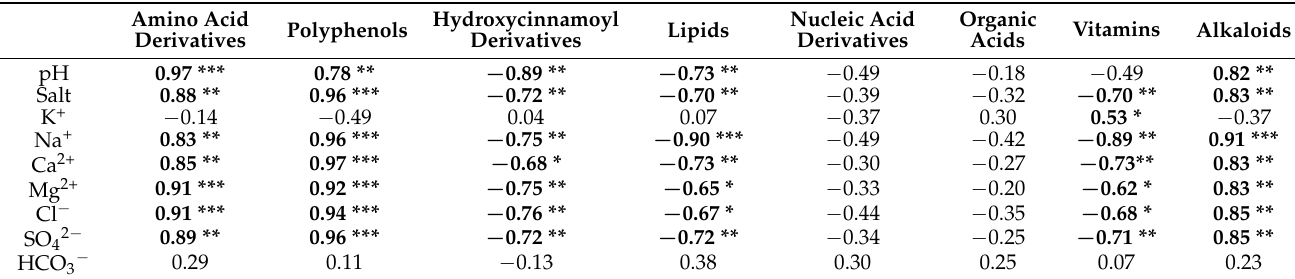
Table 3. Correlations between soil physico–chemical properties and major metabolites in wolf- berry fruits.